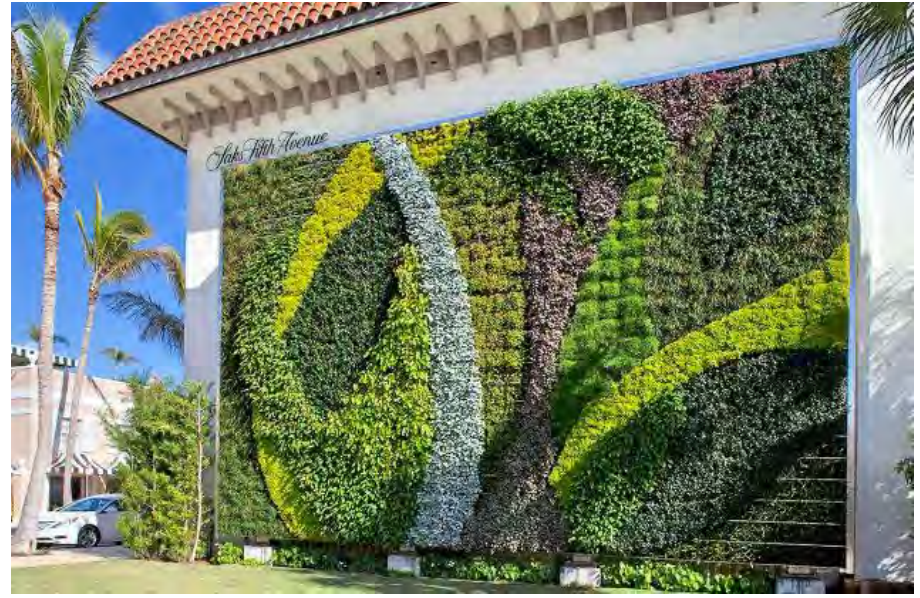
Fig. 12: Outdoor vertical garden (Gsky, 2019)